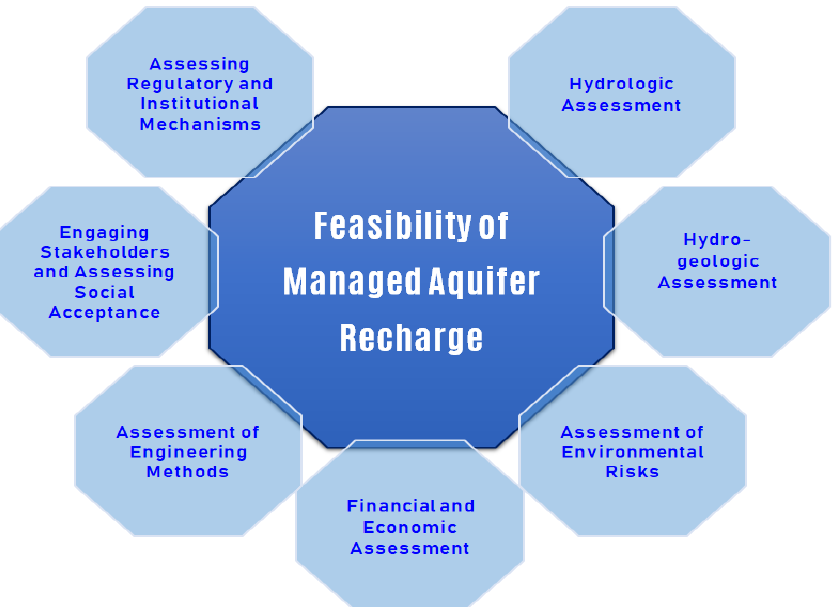
Figure 8. Framework for evaluating the feasibility of managed aquifer recharge (source: [185].